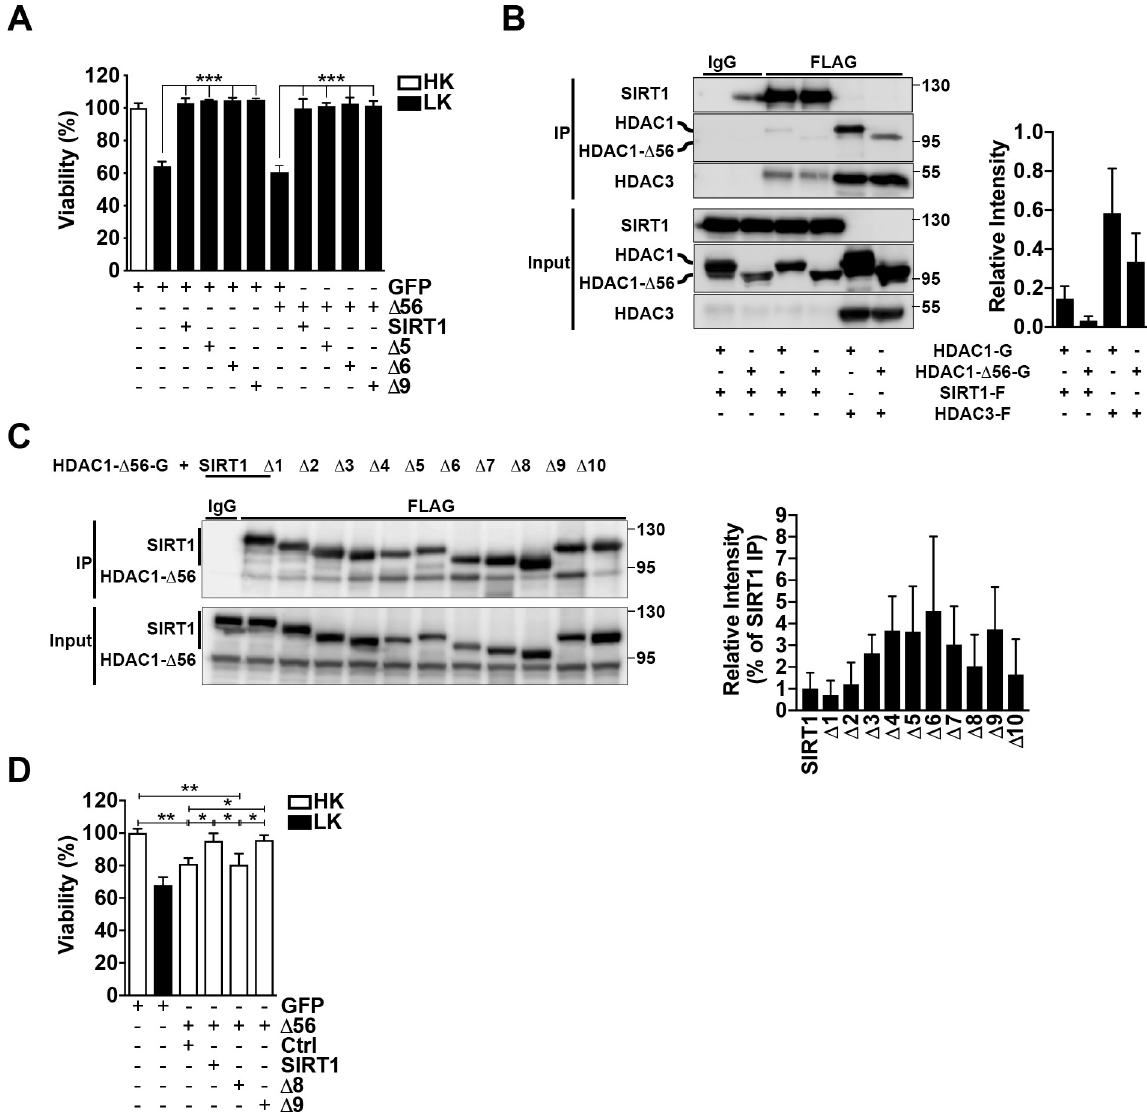
Fig 5. SIRT1 does not require HDAC1 activity. A . CGNs were expressed with GFP alone or co-expressed with SIRT1, Δ 5, Δ 6, or Δ 9 in a 1:2 ratio with GFP or Δ 56 and then treated as indicated ( ��� p < 0.001; n = 3). B. SIRT1-Flag or HDAC3-Flag were each expressed in a 1:1 ratio with either HDAC1-GFP or Δ 56-GFP into HEK293T cells for 48 h after which immunoprecipitation was performed with either and IgG or Flag antibody. Western blots were initially probed for GFP and subsequently probed for Flag. Graph shows densitometry from four independent experiments. C . Δ 56 was expressed into HEK293T cells in a 1:1 ratio with SIRT1 or Δ 1- Δ 10 for 48 h. Immunoprecipitation was performed as described in (B). Graph shows densitometry (one-way ANOVA with Dunnett’s multiple comparisons posttest) from five independent experiments. CGNs were co-transfected with GFP or Δ 56-GFP and either a control vector (Ctrl, 3xFLAG), SIRT1-Flag, Δ 8-Flag, or Δ 9-Flag in a 1:2 ratio ( � p < 0.05, �� p < 0.01; n =